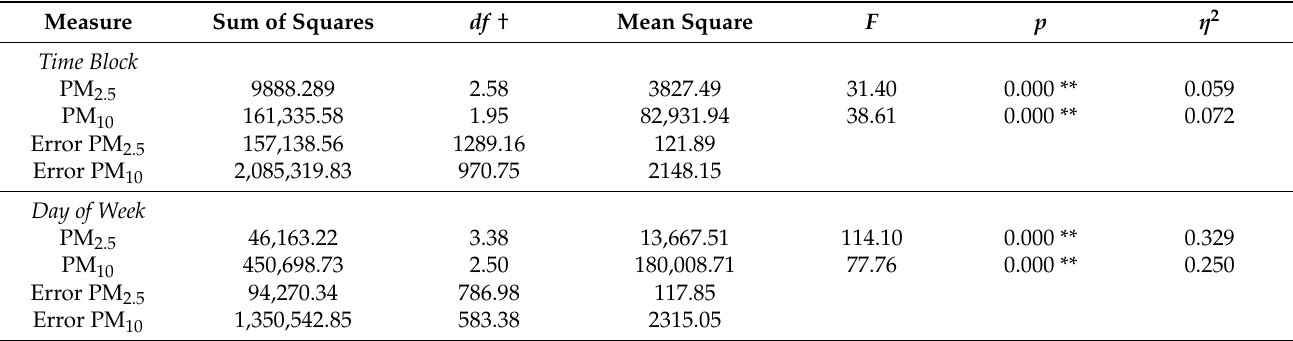
Table 1. PM density by time block and day of